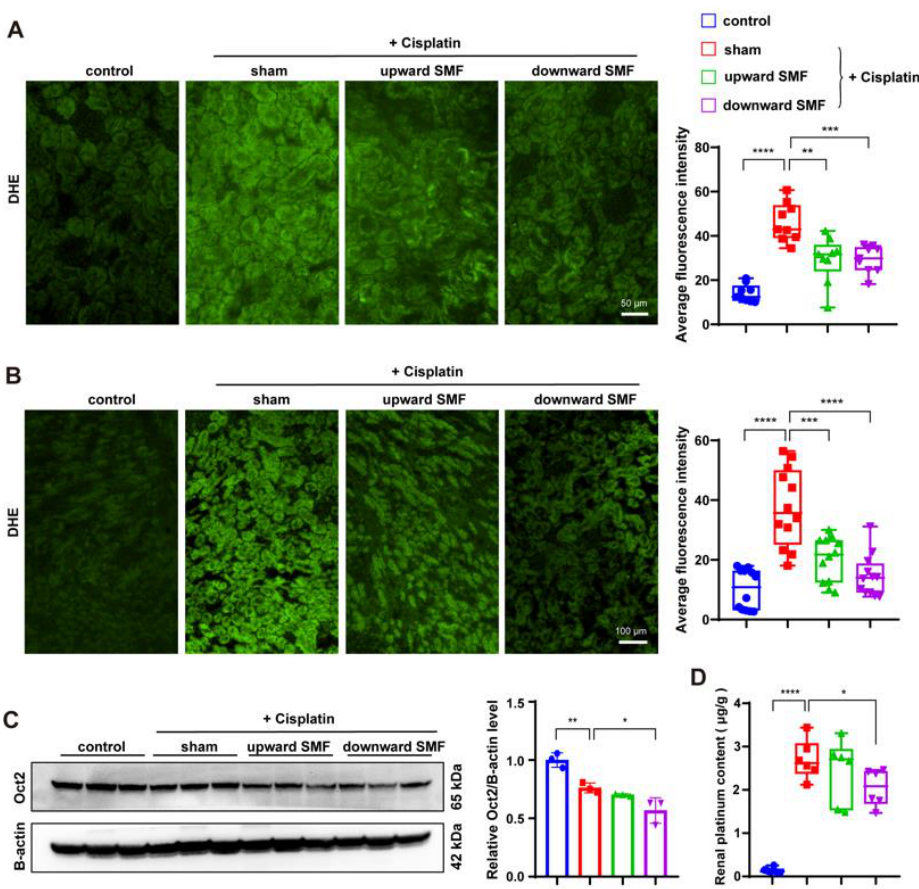
Figure 6. SMFs reduce ROS, Oct2 and cisplatin levels in cisplatin-treated mice’s kidneys. ( A , B ) Representative images and quantifications of ROS staining in the kidneys of mice: low-dose multiple-injection cisplatin-treated kidneys ( A ) and high dose single-injection cisplatin-treated kidneys ( B ). ( C ) Representative Western blotting and quantification of Oct2 in low-dose multiple-injection cisplatin-treated kidneys. Three mice were examined for each group. ( D ) ICP-MS was used to measure platinum concentration in low-dose multiple-injection cisplatin-treated kidneys. Values are expressed as means ± SD, * p < 0.05; ** p < 0.01, *** p < 0.001, **** p < 0.0001.